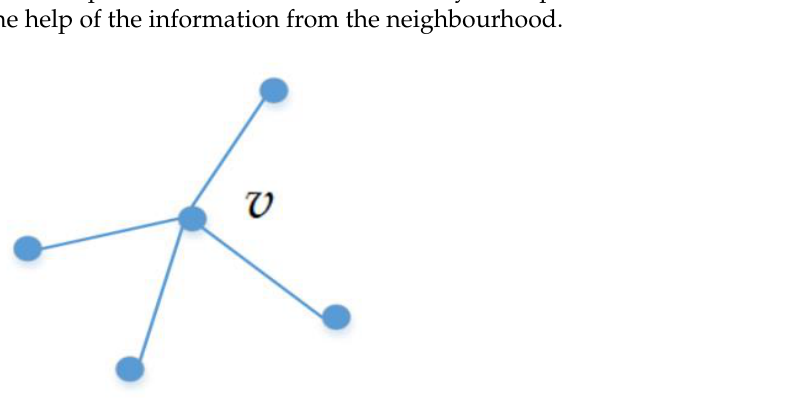
Figure 1. The node v and its neighbourhood.